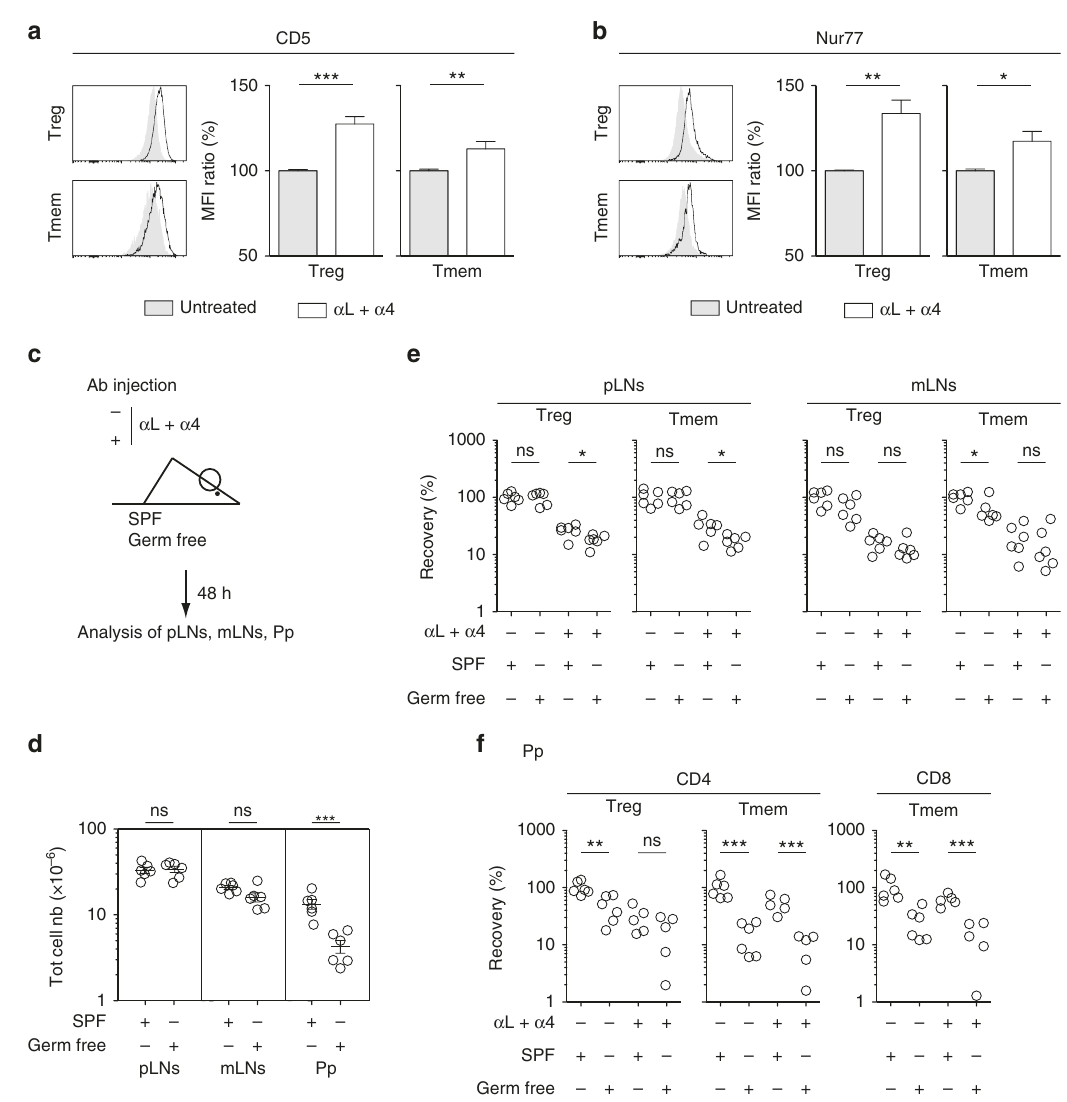
Fig. 5 Assessing the relative role of self antigens and microbiota in T cell residence in SLOs. a – c 6 – 12-week-old C57BL/6 Foxp3-GFP mice were injected or not i.p. with 200 μ g of anti-LFA-1 ( α L) and anti-VLA-4 ( α 4) Abs. Forty-eight hours later, peripheral lymph nodes (pLN) were harvested and analyzed. CD5 ( a ) and Nur77 ( b ) fl uorescence histograms of CD4 Treg and CD4 Tmem cells from the pLNs of a representative treated and a representative control C57BL/6 Foxp3-GFP mouse. Quanti fi cation is shown as means ± SEM with unpaired t -test on the right part of these panels. c – f 6 – 8-week-old SPF or germ- free C57BL/6 mice were injected or not i.p. with 200 μ g of anti-LFA-1 ( α L) and anti-VLA-4 ( α 4) Abs. Forty-eight hours later, SLOs were harvested and analyzed. c Diagram illustrating the experimental model. d Total cell numbers recovered from pLNs, mLNs, and Peyer ’ s patches (Pp) of SPF or germ-free mice. e Recovery of CD4 Treg and CD4 Tmem cells in pLNs and mLNs. f Recovery of CD4 Treg, CD4 Tmem and CD8 Tmem cells in Peyer ’ s patches (Pp). Each dot represents an individual mouse (unpaired t -test). * p < 0.05, ** p < 0.01, *** p < 0.001. ns not signi fi cant. Mouse clip arts were generated in